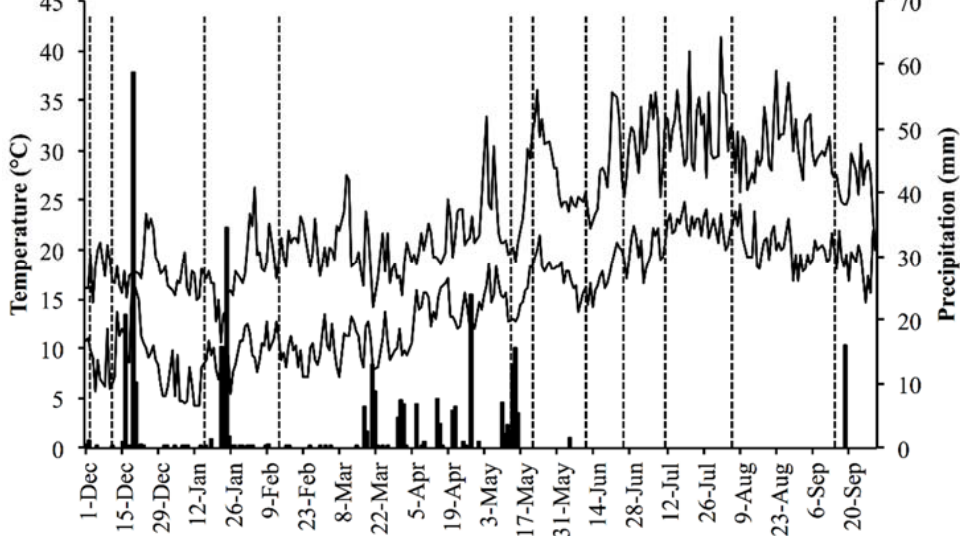
Figure 1. Daily maximum and minimum air temperatures ( ° C) (lines) and precipitation (mm) (columns) from December 2019 to September 2020 in the Odiel Marshes. Vertical dashed lines indicate sampling dates.